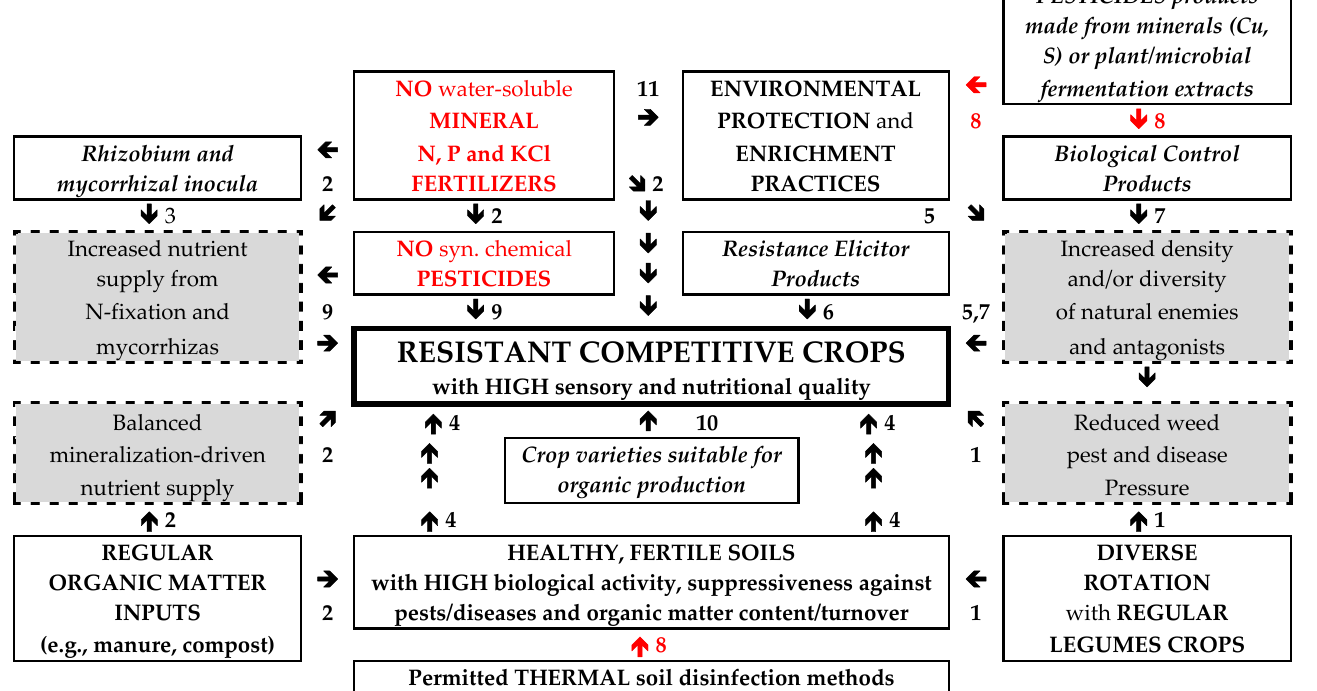
Figure 1. Logical Framework for organic crop-production systems (adapted from Leifert et al. [24]). Black text in white background describes inputs and practices permitted in organic farming; black text in boxes with grey background surrounded by dotted lines indicates an agronomically desirable effect of permitted inputs and practices or the non-use of agrochemicals; black text in boxes with white background surrounded by solid lines describes agronomic practices permitted and/or recommended in organic farming; red text in white background boxes surrounded by solid black lines describes inputs that are prohibited in organic farming. Black arrows indicate desirable impacts; red arrows indicate undesirable impacts. 1 , see also Section 2.1; 2 , see also Sections 2.2.1 and 2.2.2; 3 , see also Section 2.2.3; 4 , see also Section 2.3.1; 5 , see also Section 2.3.2; 6 , see also Section 2.3.3; 7 , see also Section 2.3.4; 8 , see also Section 2.3.5; 9 , see also Section 2.3.6; 10 , see also Section